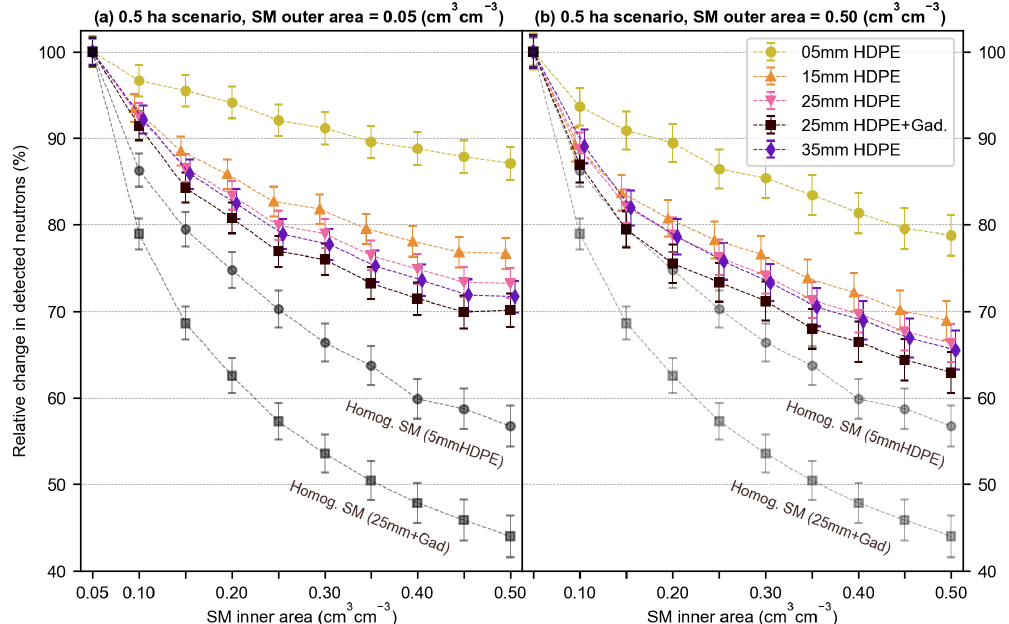
Figure 6. Relative change in number of detected neutrons due to SM variations obtained using different moderators (i.e. 5, 15, 25, and 35mm HDPE and 25mm HDPE with gadolinium shielding) for (a) 0.05 and (b) 0.50cm 3 cm − 3 SM in the outer area of a 0.5ha field. The error bars indicate the relative error in the simulations. Grey circles and squares indicate the relative change for two selected moderators when the SM changes from 0.05 to 0.50cm 3 cm − 3 are applied to the entire simulation